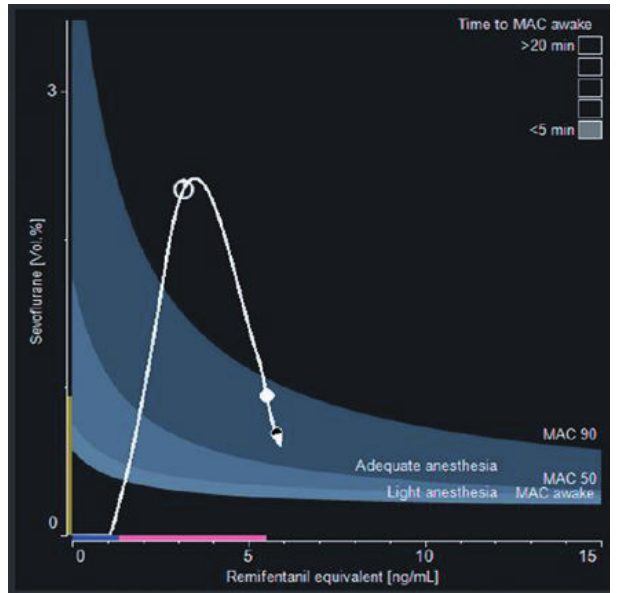
Figure 4. Real-time display of the probability of response to noxious and non-noxious stimuli as a function of hypnotic and opioid predicted concentration. Example of the SmartPilot View™ device (Dräger Medical, Lübeck, Germany). Dark grey area: 50%–90% probability of no motor response to incision. Light grey area: 50%–90% probability of no response to verbal command. White dot: current position of the patient. White arrow: future position in the next 10 minutes without changes in the dosing. White line: past pathway of the patient status since induction. During surgery, this display should complete clinical evaluation: if a patient is responding, it suggests that he or she should be shifted to a deeper anesthesia isobole until the noxious stimulation